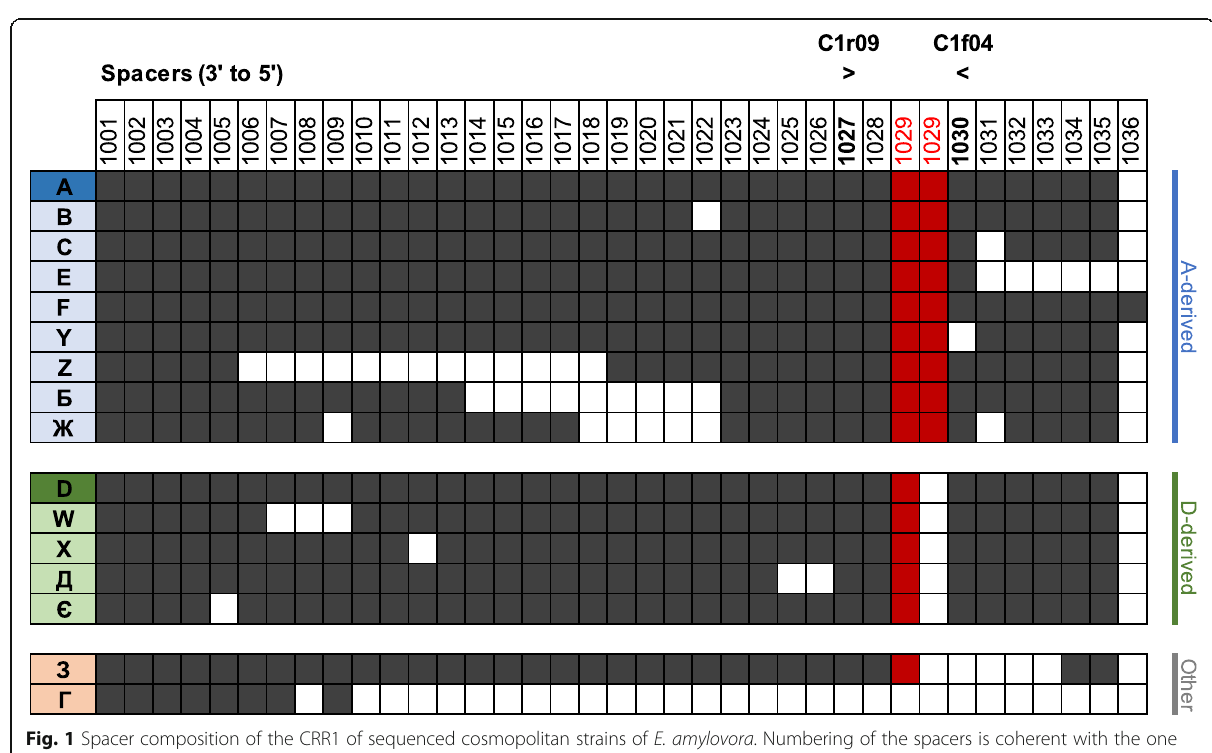
Fig. 1 Spacer composition of the CRR1 of sequenced cosmopolitan strains of E. amylovora . Numbering of the spacers is coherent with the one proposed earlier (Rezzonico et al. 2011), with the first digit corresponding to the number of the CRR followed by a three-digit number that increases from the most ancient to the more recent spacers (3 ′ to 5 ′ direction in the DNA). Sixteen different genotypes were recorded, which could be divided into three different groups (A-derived, D-derived, other) depending on the archetypal genotype from which they are probably originating. Spacer 1029 is highlighted in red, while the position of the C1f04/C1r09 primers developed to verify its number of copies via PCR is indicated by the arrows. It is worth to note that even if the Y genotype clearly evolutionarily belongs to the A-derived group, it would result in no amplification in the PCR assay due to the absence of spacer 1030 that is the annealing site of primer C1f04. For the purpose of our study, this genotype and related strain ACW65131 were nevertheless assigned to the A-derived genotypes to which they clearly belong. One typical representative for each genotype, including geographical origin and year of isolation, is listed hereafter. A: CFBP 1252 (UK 1958), B: Ea273 (USA 1971), C: Ea02 (CH 2002), E: Ea153 (USA 1989), F: Ea263 (IL 1997), Y: ACW65131 (CH 2009), Z: K18 (KZ 2013), Ƃ : KBE1 (RU 2009), ж : Tk86 (TK